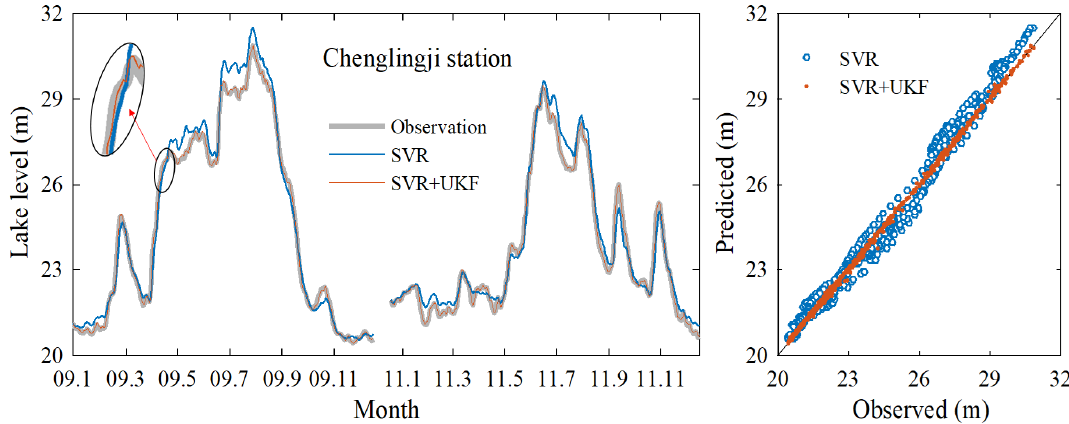
Figure 6. Comparisons between Chenglingji water levels predicted with SVR and SVR+UKF.